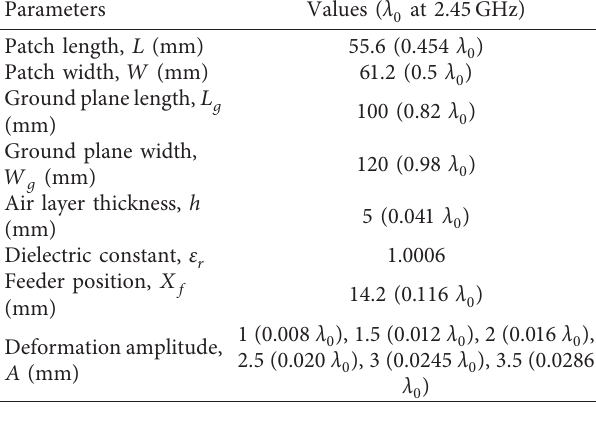
Table 1: Physical parameters of air microstrip antenna. Parameters Values ( λ